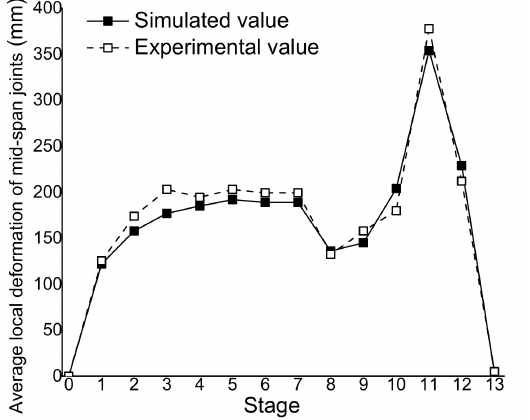
Figure 18. Average local deformation of the mid-span temporary hinged